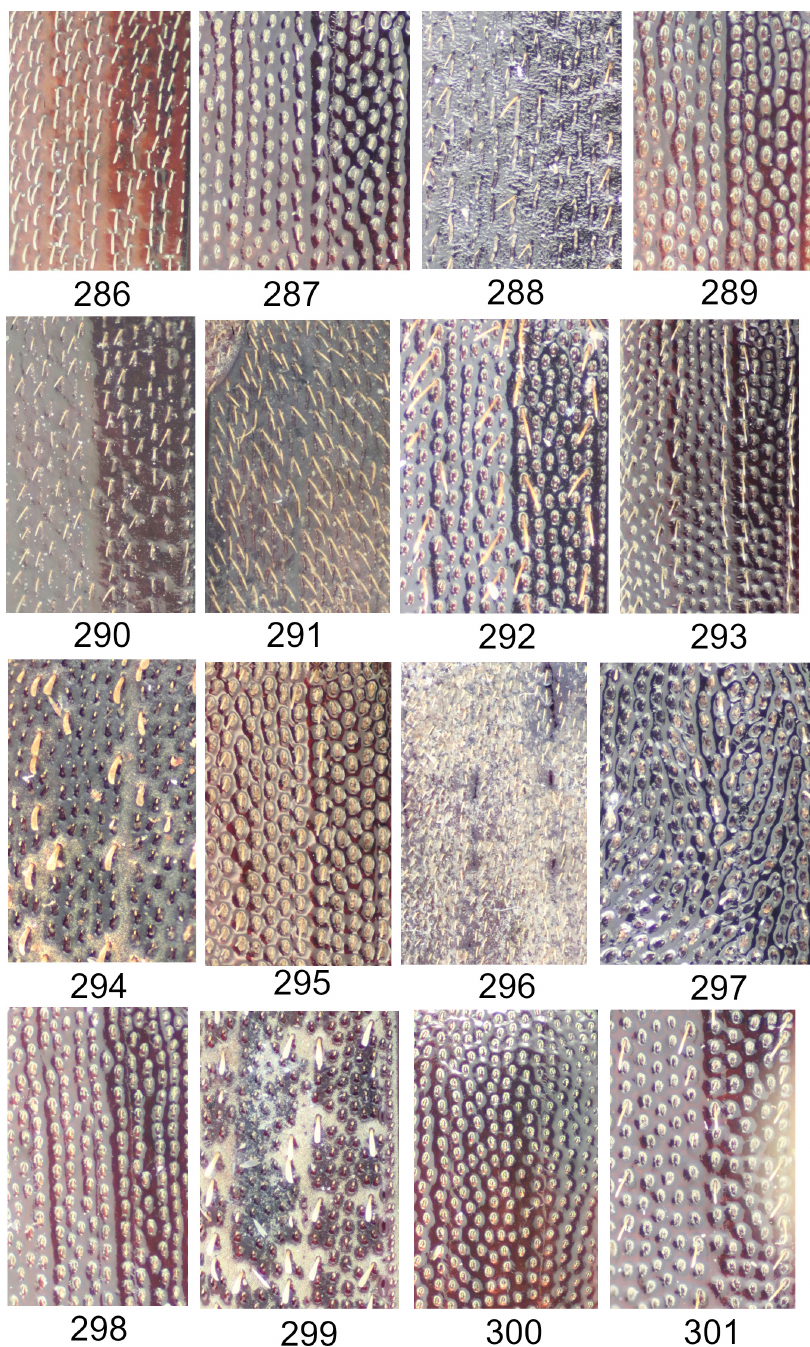
Figs 286–301. Papuan and Wallacean Maechidius Macleay, 1819, elytron, dorsal view. 286 . M. aenescens Heller, 1910, lectotype, ♀ (SNSD) . 287 . M. aiyura sp. nov., holotype, ♂ (BMNH). 288 . M. alesbezdeki sp. nov., holotype, ♂ (NME). 289 . M. angusticeps Arrow, 1941, holotype, ♂ (BMNH). 290 . M. aroae Heller, 1914, lectotype, ♀ (SNSD). 291 . M. paupianus Heller, 1910, ♂ (BMNH). 292 . M. awu sp. nov., holotype, ♂ (IECA). 293 . M. babyrousa sp. nov., holotype, ♂ (BMNH). 294 . M. bintang sp. nov., holotype, ♂ (NME). 295 . M. boessnecki sp. nov., holotype, ♂ (SNSD). 296 . M. brocki sp. nov., holotype, ♂ (BMNH). 297 . M. caperatus sp. nov., holotype, ♂ (NME). 298 . M. ciliatus sp. nov., holotype, ♂ (IECA). 299 . M. crypticus sp. nov., paratype, ♀ (BMNH). 300 . M. dani sp. nov., holotype, ♂ (IECA). 301 . M. deltouri sp. nov., holotype, ♂ (BMNH). Not to